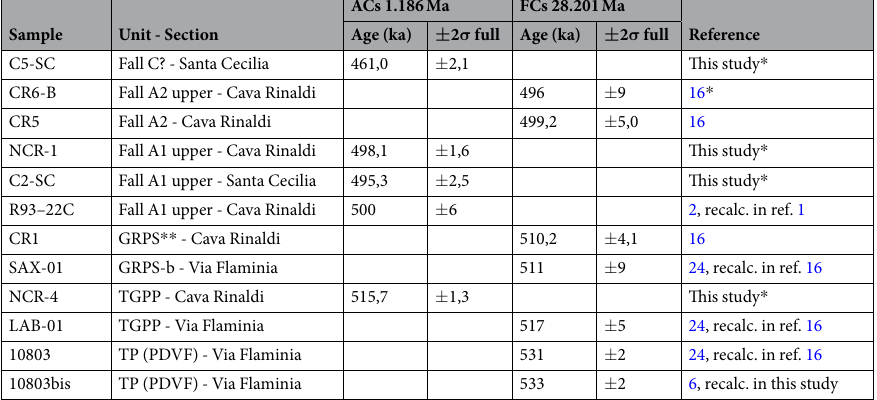
Table 1. Summary of new and published 40 Ar/ 39 Ar ages from the Valle Giulia Formation. * Data obtained at the University of Wisconsin-Madison. All other published data obtained at Berkeley Geochronology Center. ** Previously interpreted as TGPP 16 . 2 σ full includes analytical and systematic (i.e. decay constant) uncertainties. TP: Tufo del Palatino; PDVF: Peperino della Via Flaminia; TGPP: Tufo Giallo di Prima Porta; GRPS: Grottarossa Pyroclastic